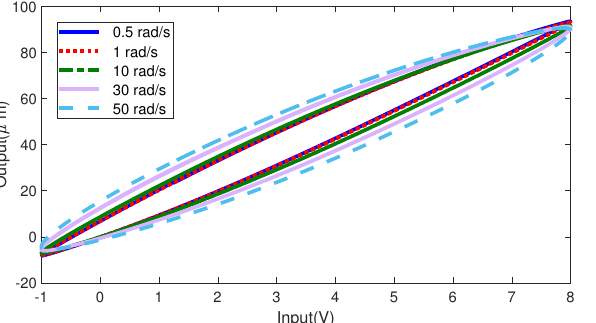
Figure 2. Hysteresis loops with five different sinusoid signal inputs of angular velocities from 0.5 rad/s to 50 rad/s.